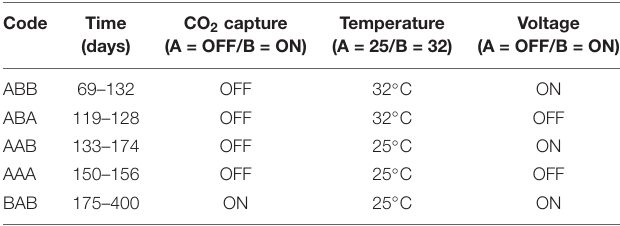
TABLE 1 | Operational conditions